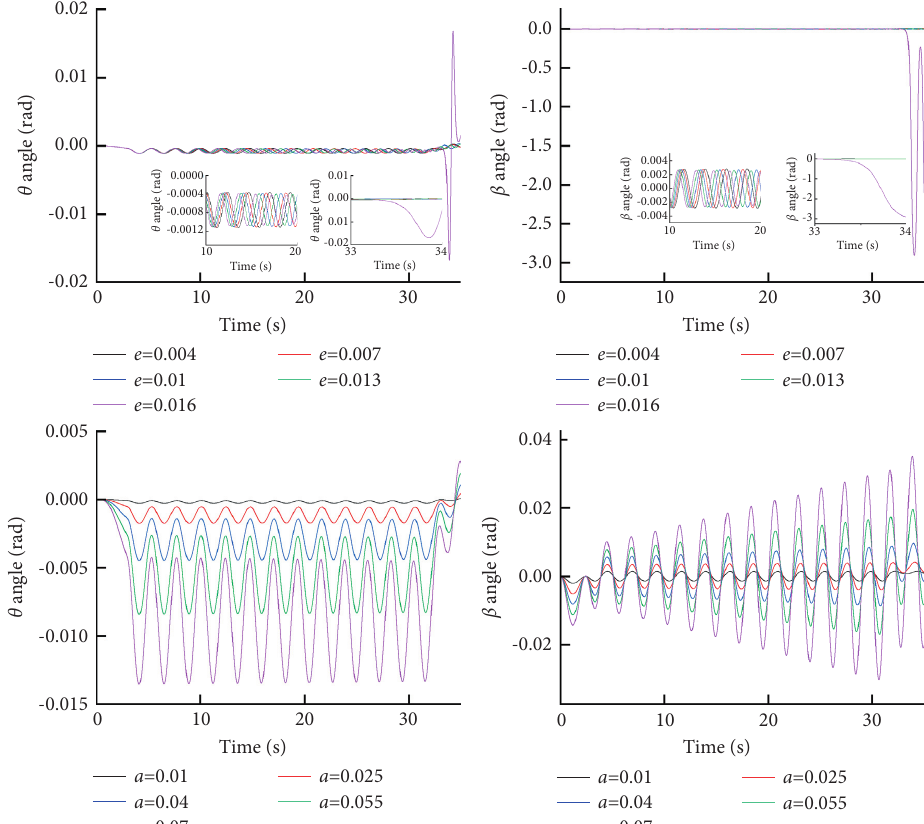
Figure 12: Response of a and e to the